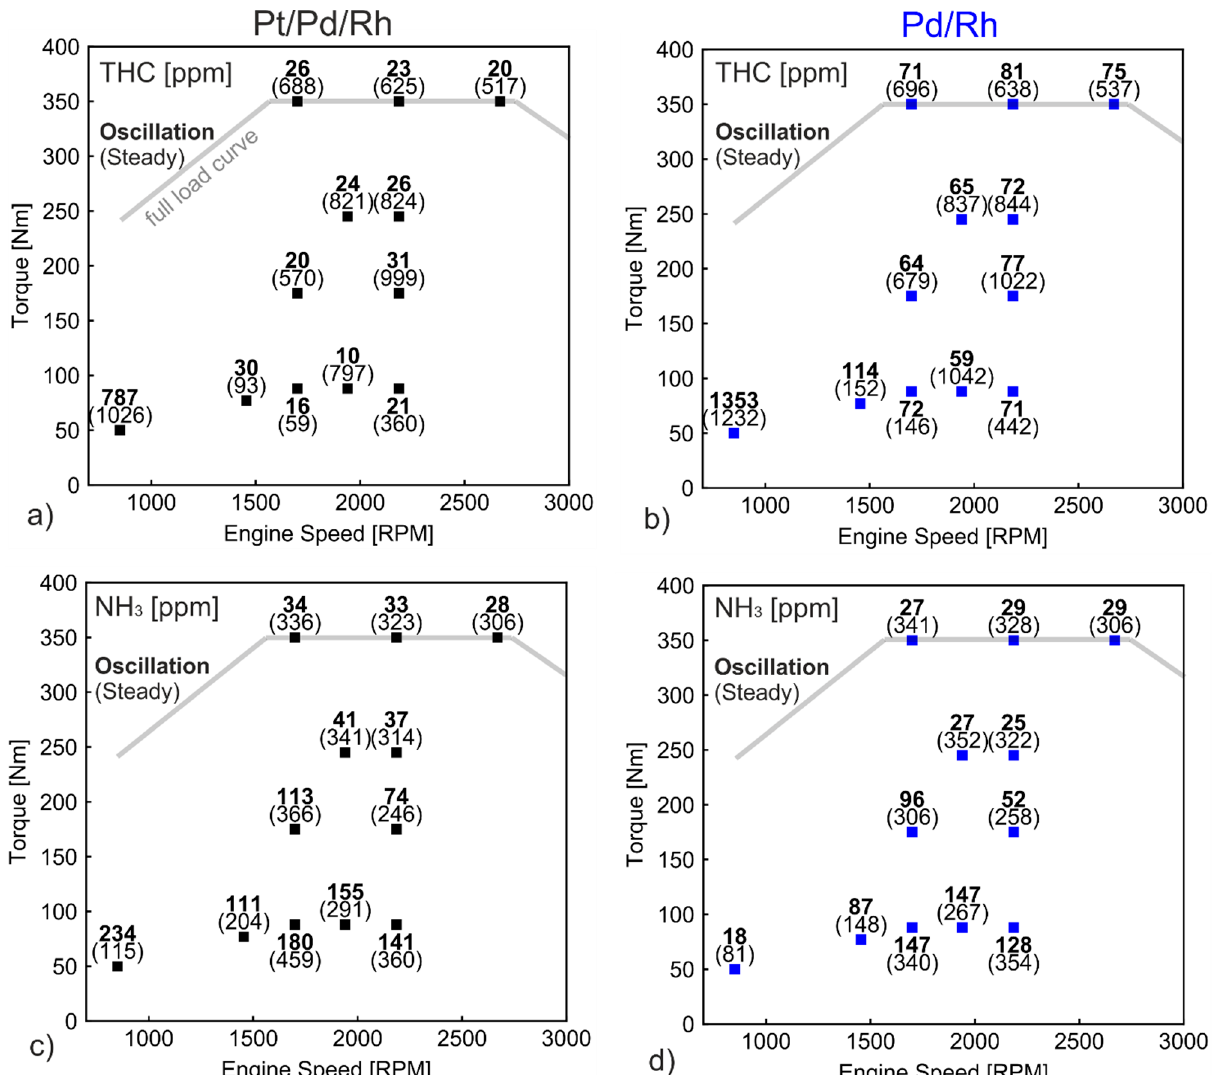
Figure 14. THC and NH 3 emission under steady and oscillations in WHSC operating points for ( a ) and ( c ) Pt/Pd/Rh catalyst; ( b , d ) Pd/Rh